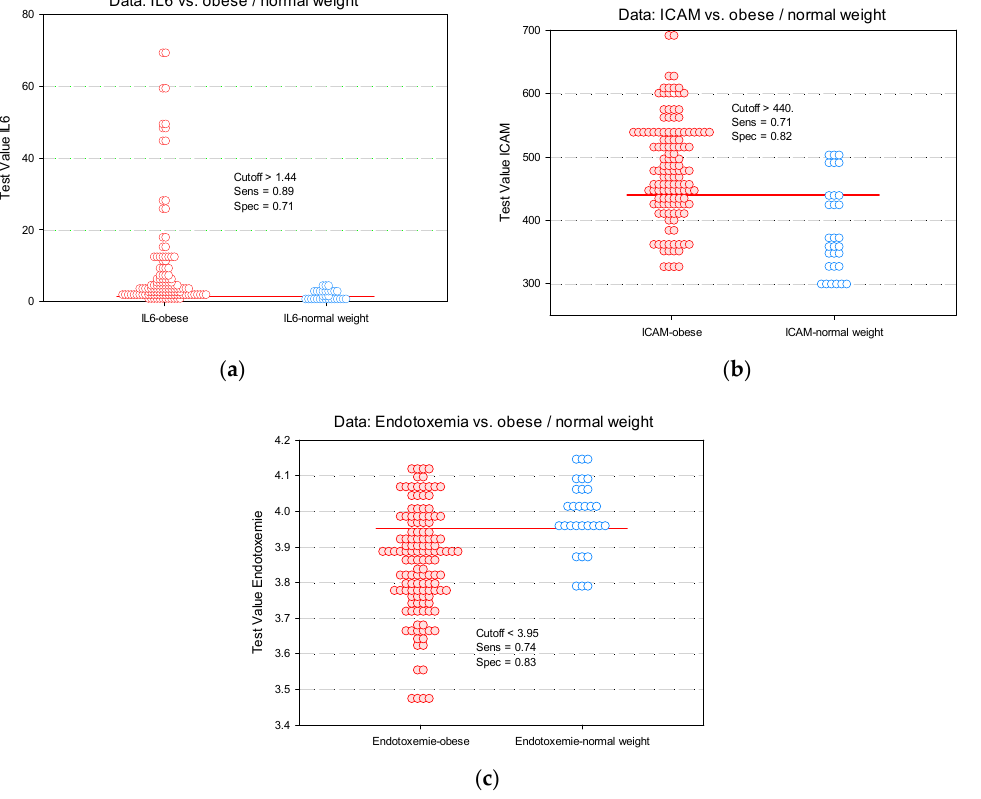
Figure 4. Identifying cut-off values predictive for vascular impairment in obese children (dot histogram) for: ( a ) IL-6; ( b ) ICAM; ( c ) endotoxemia.